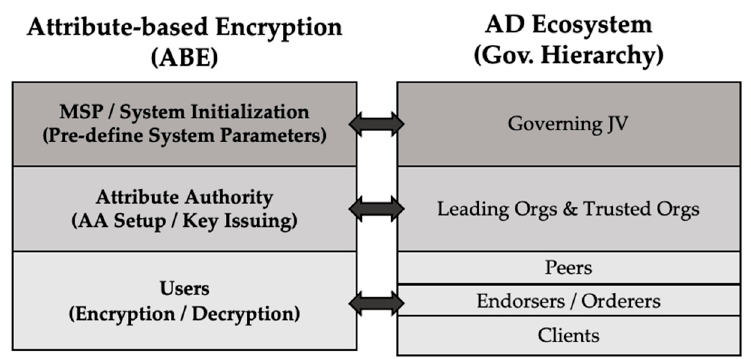
Figure 6. Mapping of ABE functionalities/AD organizations. Reference: [85].